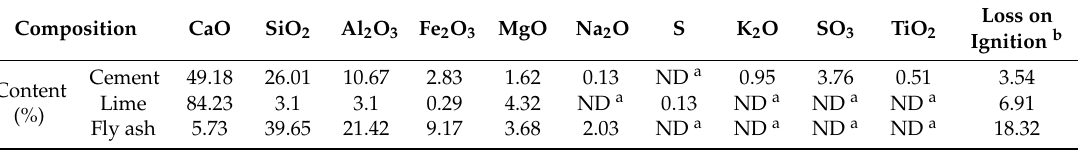
Table 2. Mineral composition and relative content of